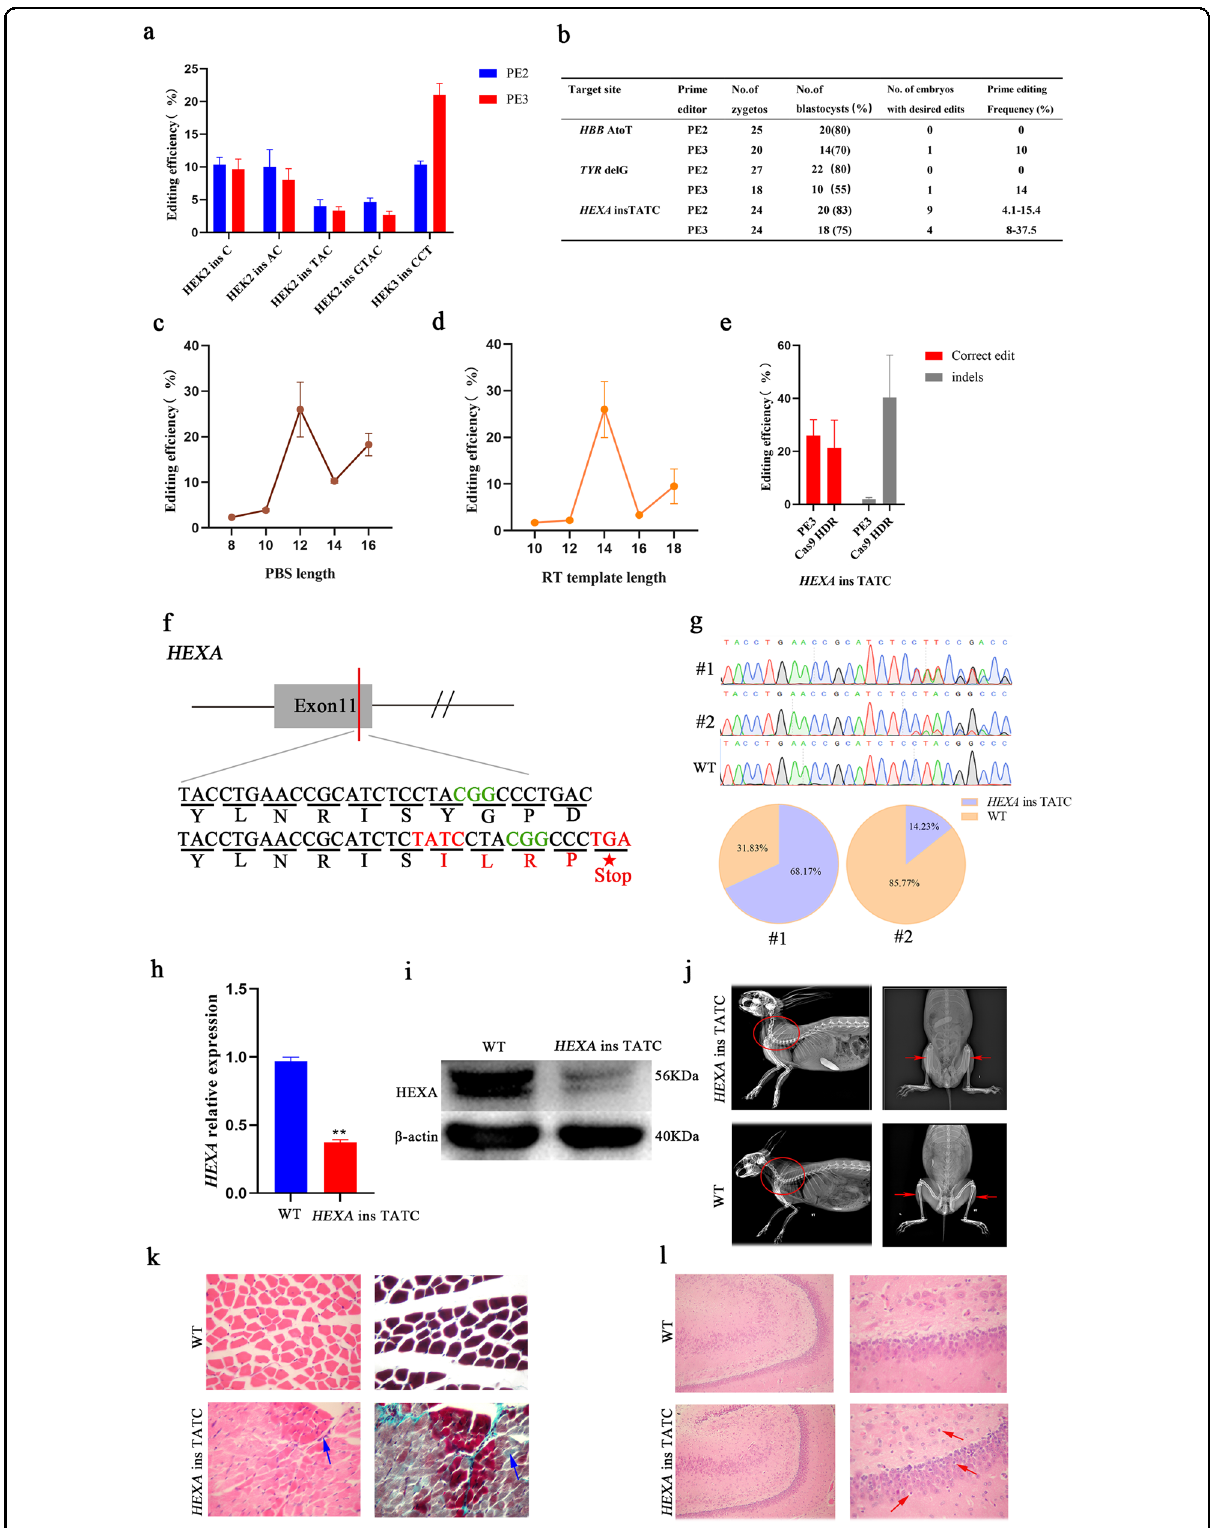
Fig. 1 (See legend on next